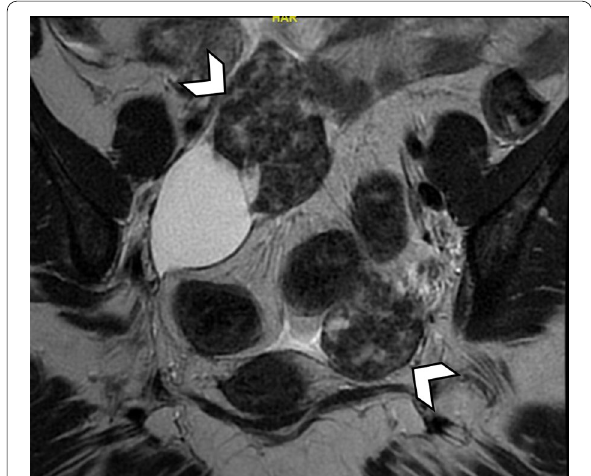
Fig. 10 Bilateral solid ovarian masses first detected on staging CT in a 54-year-old female with newly diagnosed ILC. Coronal T2-weighted MR image of the pelvis shows bilateral, solid, ovarian masses with heterogeneous low T2-weighted signal (arrowheads), suggestive of fibrous, desmoplastic components. There is an ovarian cyst adjacent to the right ovarian mass. The solid appearance of the masses and low T2-weighted signal favor Krukenberg tumors over primary ovarian malignancy. Metastatic ILC involvement was confirmed following hysterectomy and bilateral